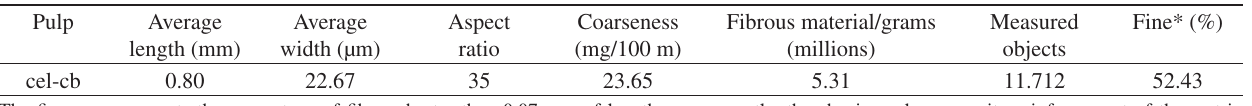
Table 3. Characteristics of the cellulose fibers of Kraft cement bag (cel-cb).